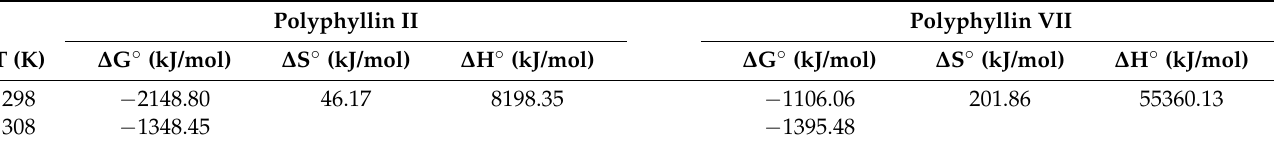
Table 6. Thermodynamic parameters for the adsorption of two saponins on NKA-9. Polyphyllin II